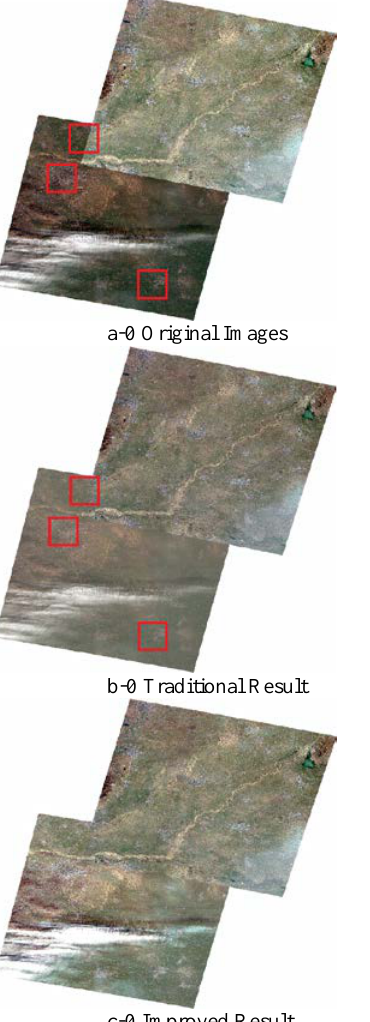
Figure 8. Wallis Transform Results